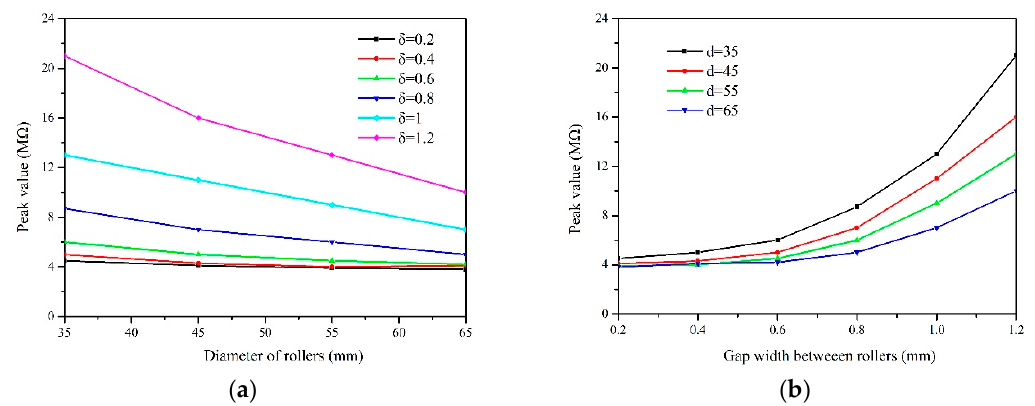
Figure 6. Peak value depending on diameter ( a ) and gap width ( b ) of the rollers for round rice with moisture content of 20.7%w.b.